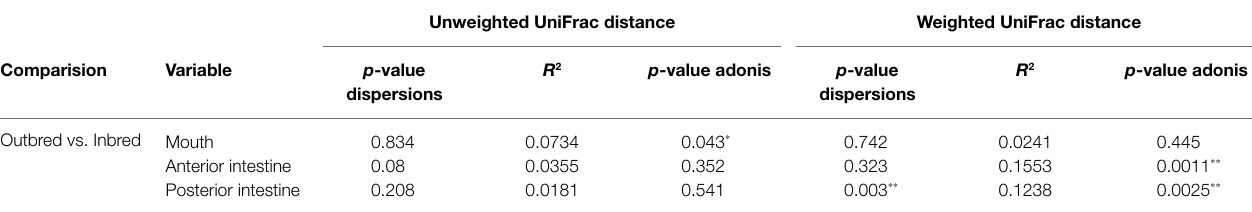
* Indicates p < 0.05 and **indicates p <